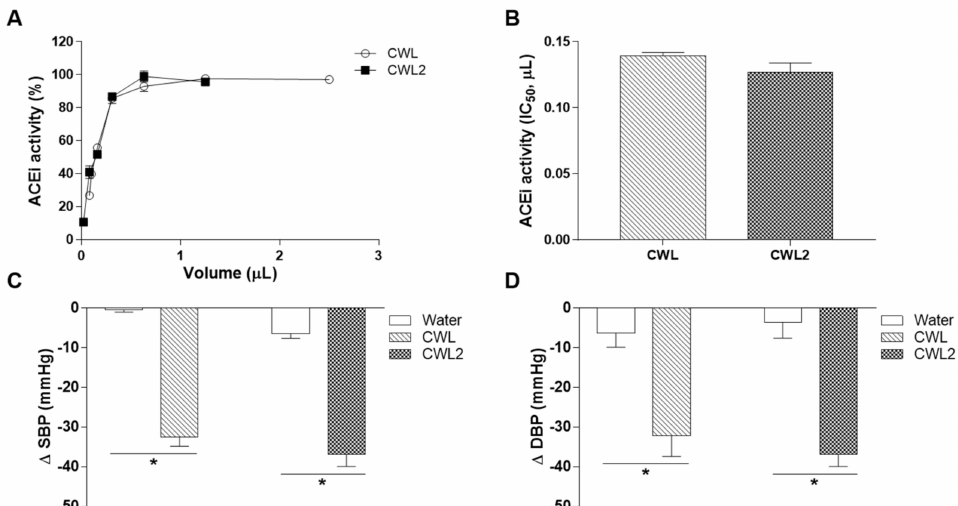
Figure 6. Variability between Cabernet wine lees (CWL) from two different harvests (CWL and CWL2). ACEi activity for both harvests is represented as dose–response curve (%, A ) and IC 50 ( B ). Data are shown as mean ± SD ( n = 3). No significant differences ( p < 0.05) were found between IC 50 values (Student’s T-test). Decrease in systolic blood pressure (SBP, C ) and diastolic blood pressure (DBP, D ) caused in spontaneous hypertensive rats by the acute administration of water, CWL, or CWL2 (both 5 mL/kg bw). Data are shown as mean ± SEM ( n = 6). No significant differences ( p < 0.05) were found between CWL and CWL2 (Student’s T-test). * represents significant differences ( p < 0.05) between CWL and CWL2 and their respective water control groups estimated by Student’s